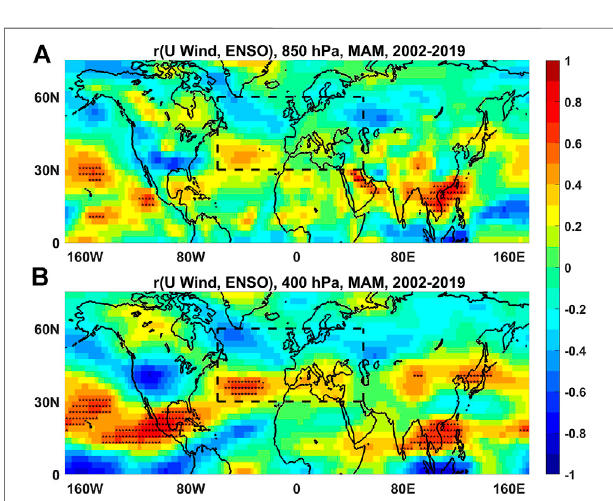
FIGURE 9 | (A) Correlation between the ENSO index and wind in the U direction at 850 hPa in MAM over 2002 – 2019, with asterisks indicating the 95% signi fi cance level. (B) The same as (A) , but at 400 hPa.